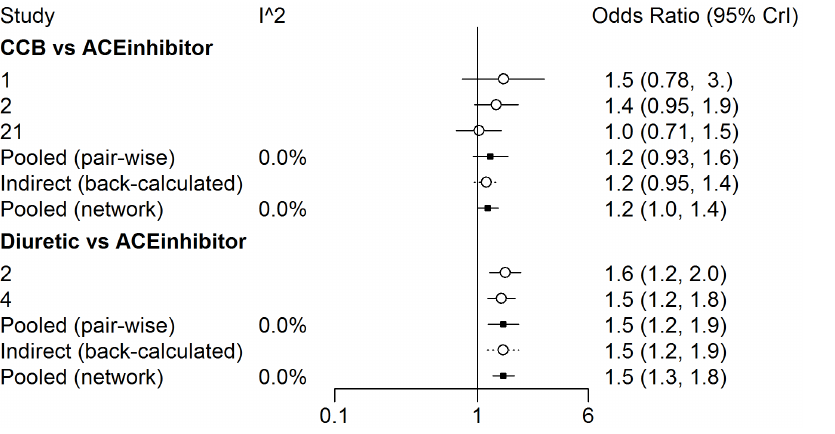
Fig. 5. A forest plot of the estimates of odds ratios between each treatment and the reference placebo created using the netmeta R package and diabetes data.